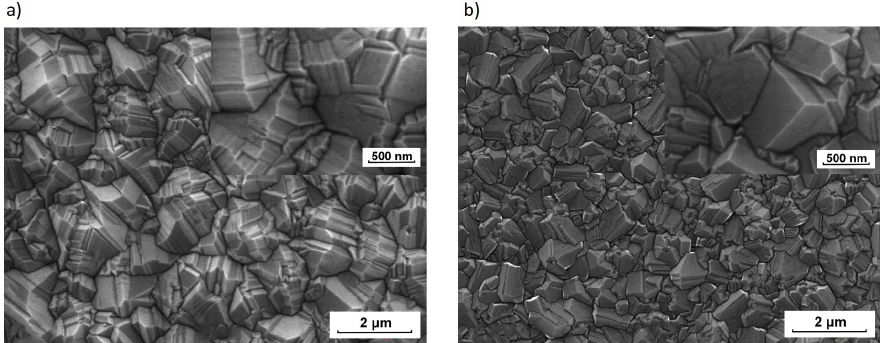
Figure 1. SEM micrographs of the diamond layers synthesized with different working gas compositions: ( a ) DFI CH 3 OH/H 2 = 1.0 vol.%, ( b ) DFII CH 3 OH/H 2 = 4.0